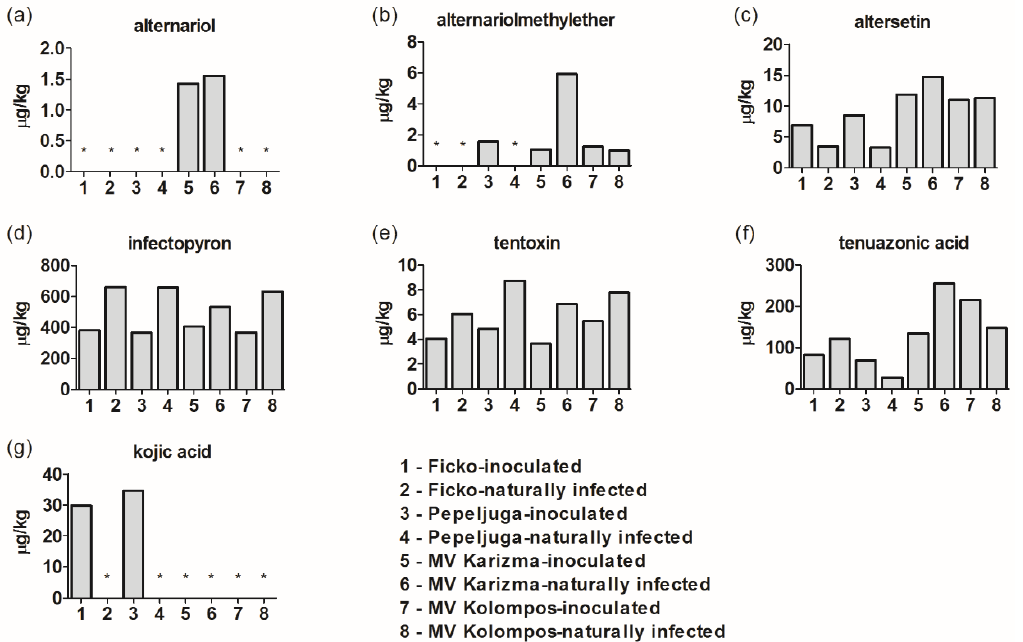
Figure 2. Alternaria and Aspergillus mycotoxins in Fusarium -inoculated and naturally-infected samples: alternariol ( a ), alternariolmethylether ( b ), altersetin ( c ), infectopyron ( d ), tentoxin ( e ), tenuazonic acid ( f ), and kojic acid ( g ). The asterisk (*) indicates < LOD.